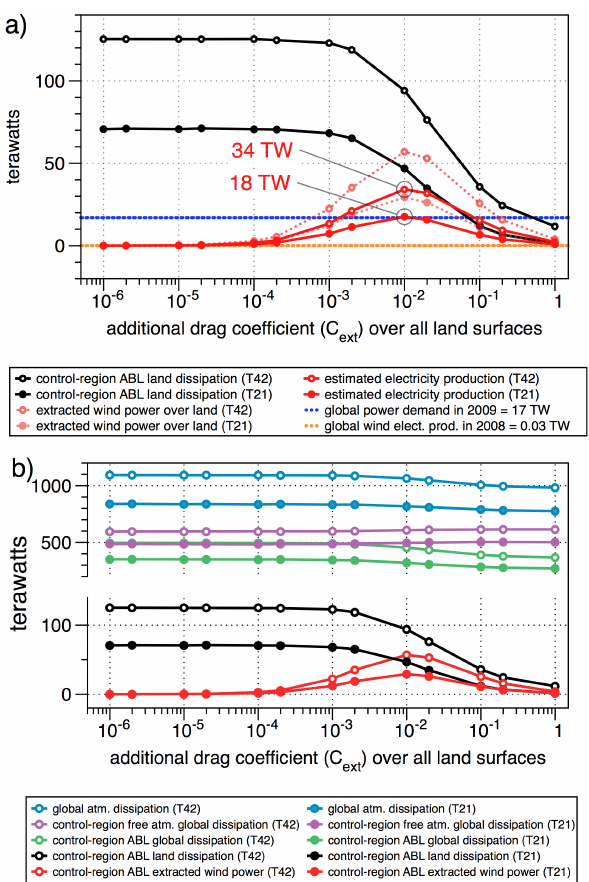
Fig. 5. In (a) sensitivity analysis between an increased drag coeffi- cient ( C ext ) over all non-glaciated land surfaces and the correspond- Fig. 5. In a) sensitivity analysis between an increased drag coef- ing impacts to atmospheric boundary layer wind dissipation over ficient ( C ext ) over all non-glaciated land surfaces and the corre- land, extracted wind power (additional turbulence + power extrac- sponding impacts to atmospheric boundary layer wind dissipation tion), and mechanical wind power for the T42 (open circles) and over land, extracted wind power (additional turbulence + power ex- T21 (closed circles) simulations with 10 vertical layers. Control- traction), and mechanical wind power for the T42 (open circles) and region corresponds to the volumetric region of the atmosphere in T21 (closed circles) simulations with 10 vertical layers. Control- the control simulation, as increased drag coefficients eventually re- region corresponds to the volumetric region of the atmosphere in sult in a new vertical compartmentalization of atmospheric bound- the control simulation, as increased drag coefficients eventually re- ary layer and free atmosphere dissipation. For reference, the dashed sult in a new vertical compartmentalization of atmospheric bound- blue horizontal line shows the estimated 17TW of global energy ary layer and free atmosphere dissipation. For reference, the dashed demand in 2009 (EIA, 2009) and the dashed orange horizontal line blue horizontal line shows the estimated 17 TW of global energy indicates the estimated 0.03TW of global electricity production by demand in 2009 (EIA, 2009) and the dashed orange horizontal line wind turbines in 2008 (World Wind Energy Association, 2008). indicates the estimated 0.03 TW of global electricity production by In (b) , the same sensitivity analysis is shown but illustrating changes wind turbines in 2008 (World Wind Energy Association, 2008). In to the global atmospheric dissipation, control-region free atmo- b) , the same sensitivity analysis is shown but illustrating changes to sphere dissipation, control-region global atmospheric boundary the global atmospheric dissipation, control-region free atmosphere layer dissipation, and control-region atmospheric boundary layer dissipation, control-region global atmospheric boundary layer dis- dissipation over land. sipation, and control-region atmospheric boundary layer dissipation over land.